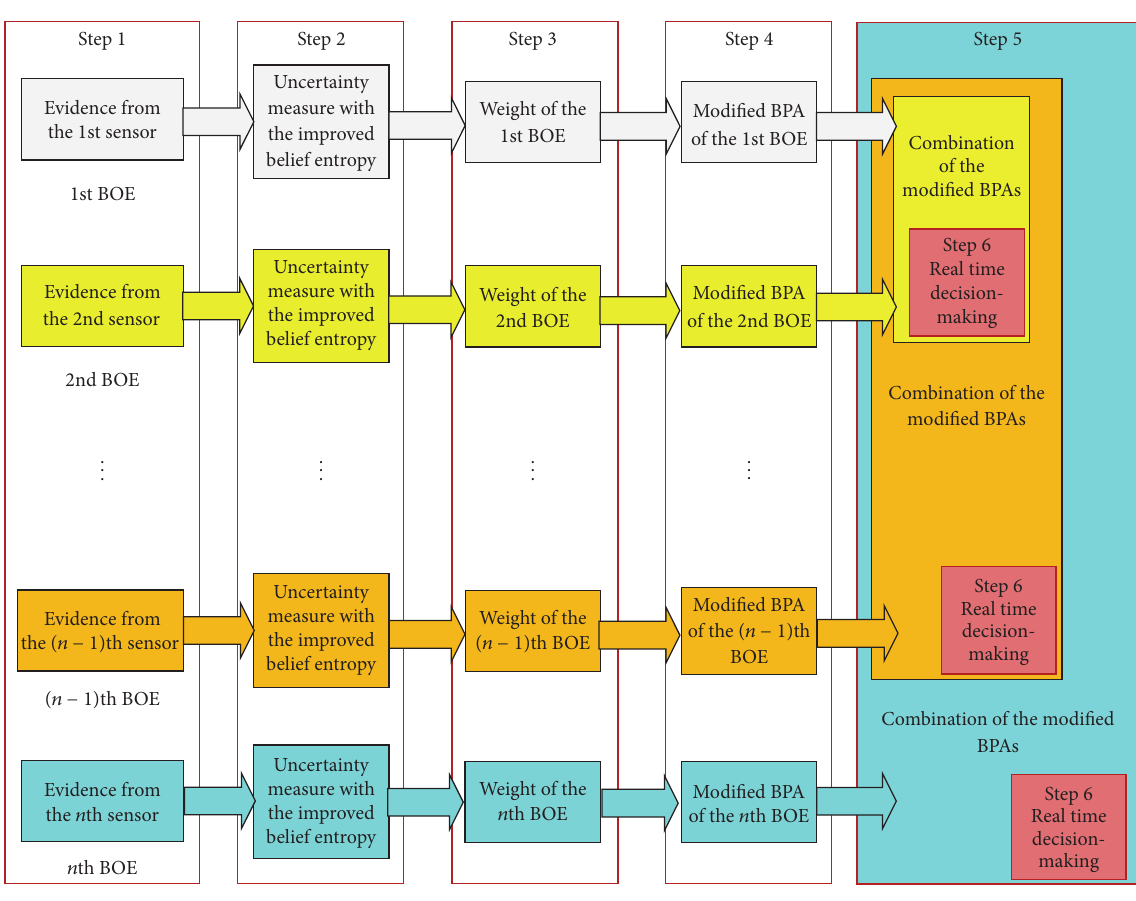
Figure 2: The flowchart of the proposed approach for